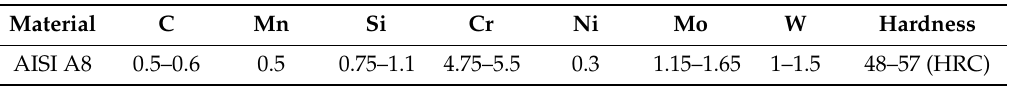
Table 1. Chemical composition in weight percentage for the studied tool steel and Rockwell C hardness after conventional heat treatment.